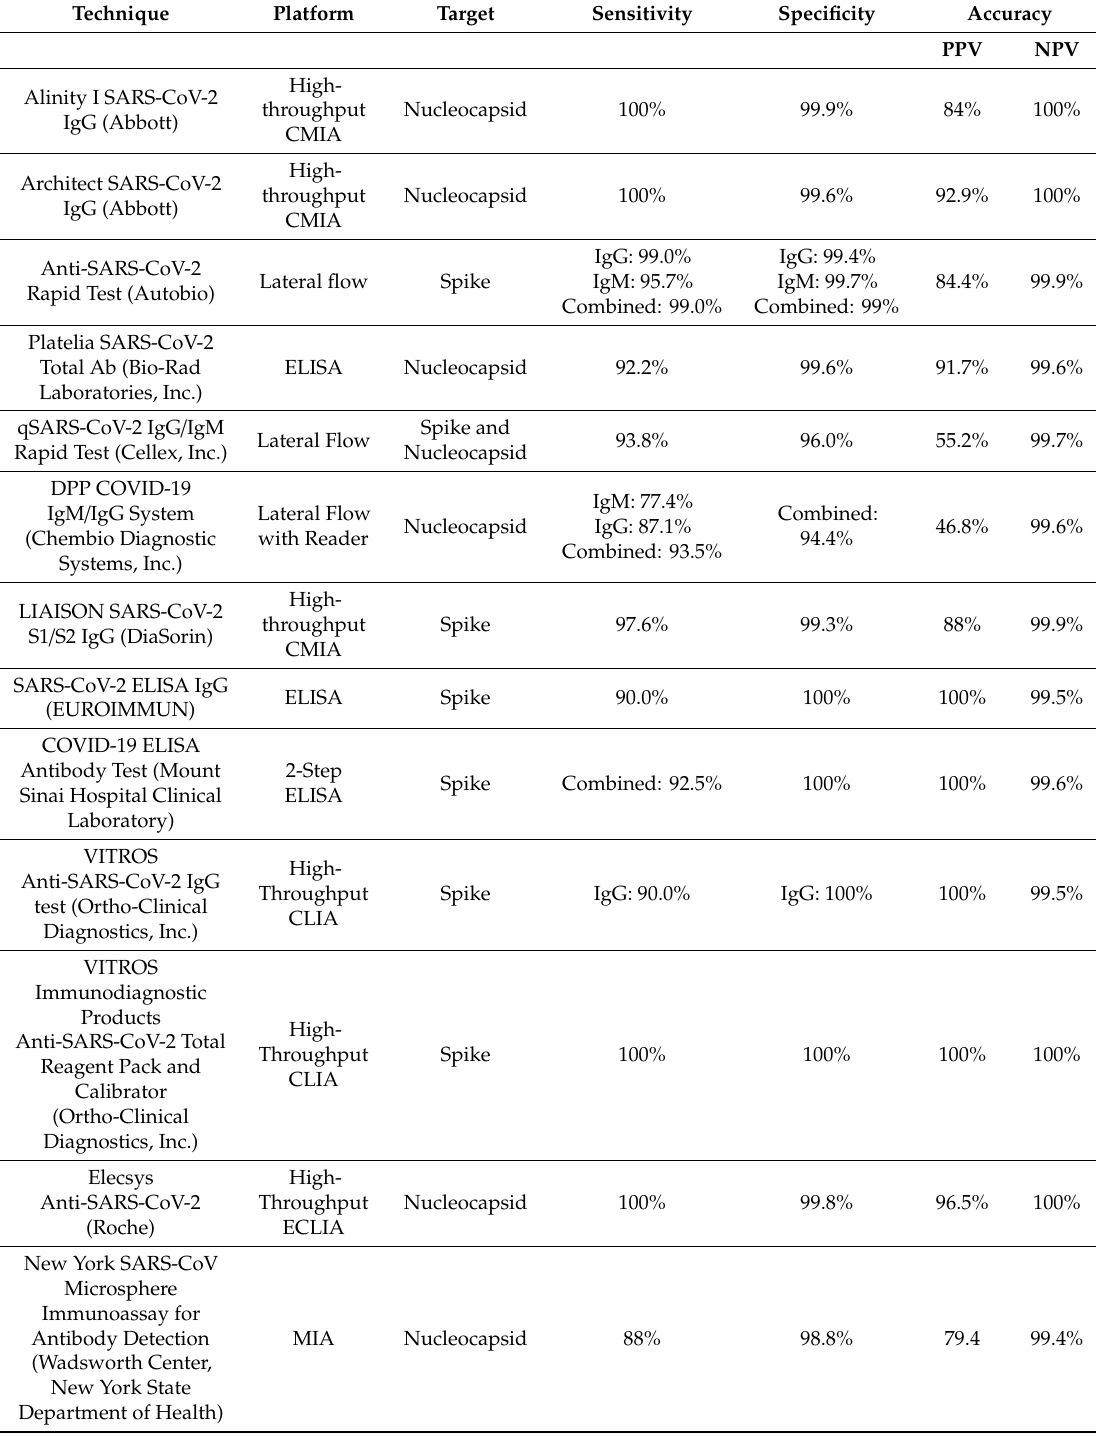
Table 2. The general list of cross-reactivity result that have been tested from diagnostic tests.